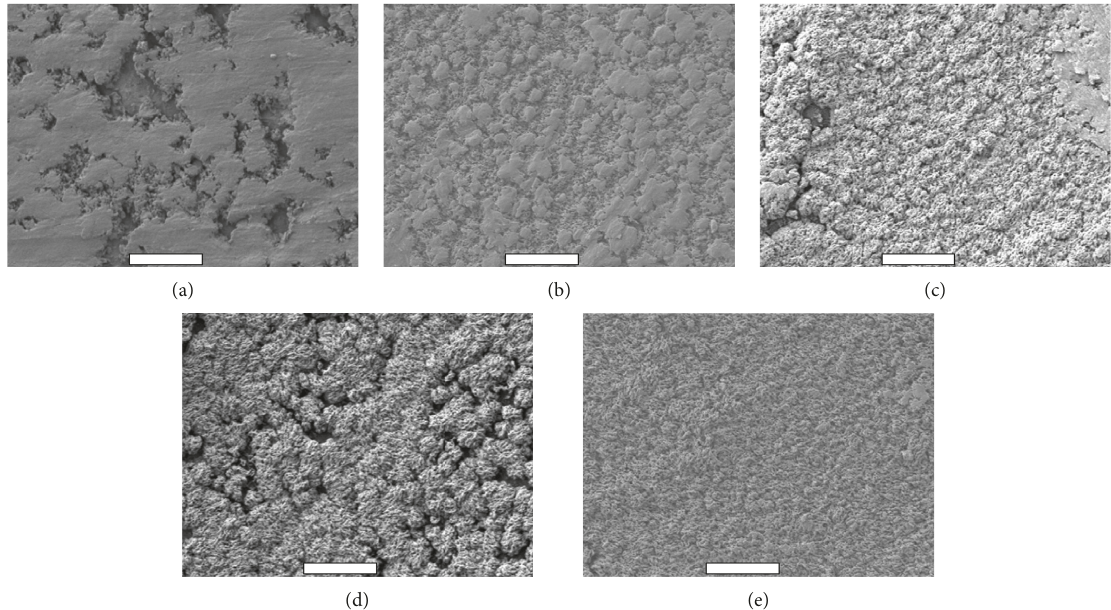
Figure 4: SEM images of (a) pristine PBS, (b) 3CB-PBS, (c) 5CB-PBS, (d) 10CB-PBS, and (e) 15CB-PBS. Scale bar shown here is equal to 10 μ